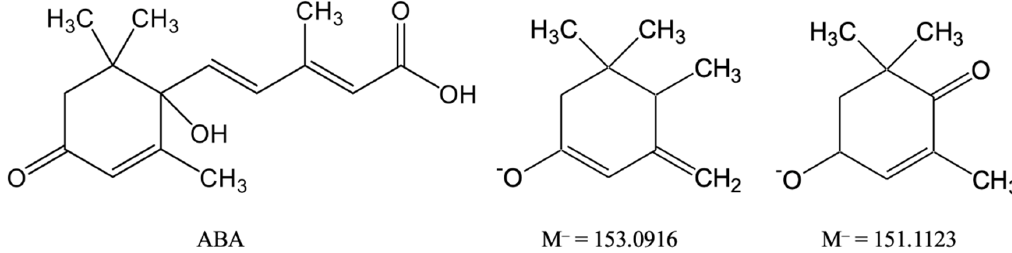
Figure 2. Calculated structures of the main ions obtained by ESI-TOF MS in negative ionization mode.